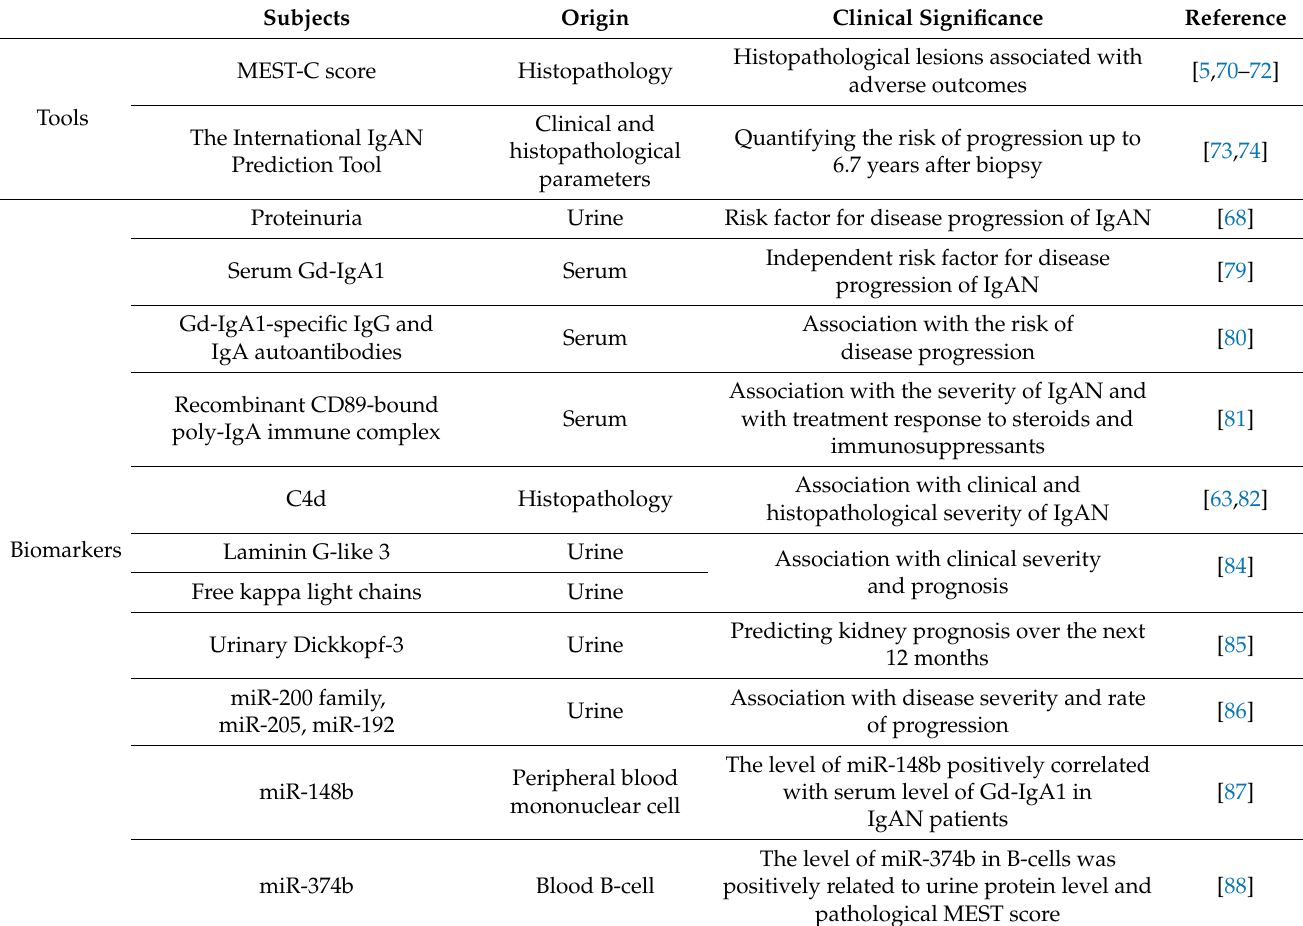
Table 2. Tools and biomarkers in the prediction and prognosis of